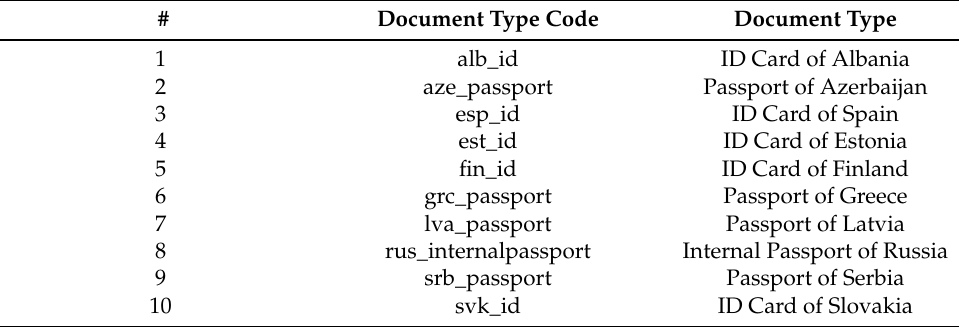
Table 1. Document types featured in DLC-2021.